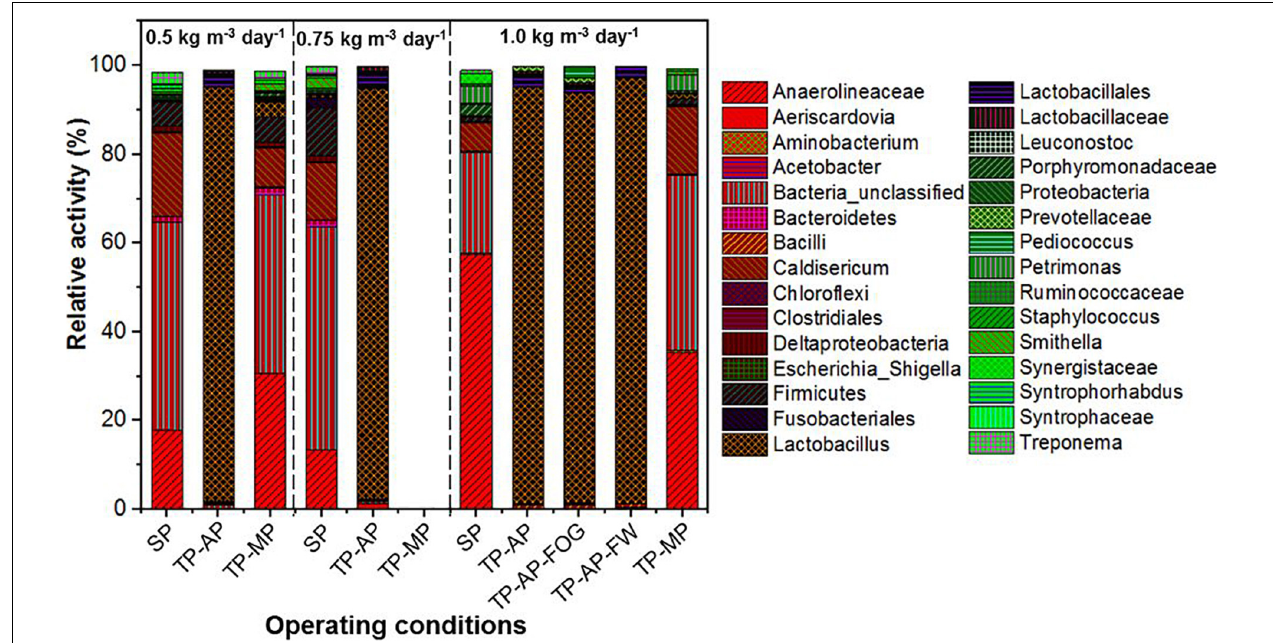
FIGURE 3 | Relative activity based on 16S rRNA sequencing identified at the genus level where possible for different fat loadings and operating conditions. All data are expressed as a percentage of total 16S rRNA sequences (bacteria) per sample point. Due to the accidental loss of extracted RNA from TP-MP-0.75 samples, no corresponding data is presented